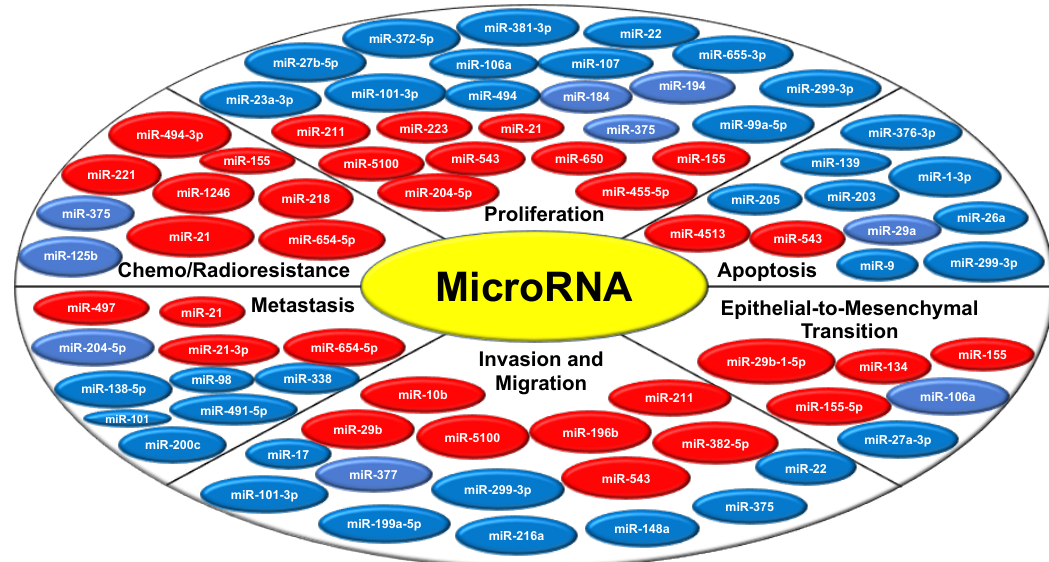
* The arrows illustrated in the first column of the table represent the expression levels of miRNA in oral cancer tissues/cell lines. The second column represent the targets of miRNA found in various studies. The third column indicates the mech- anism of action of these miRNAs in modulating various hallmarks of oral tumorigenesis. ↑ denotes increase and ↓ depicts decrease in either in expression/ function of miRNAs. Table 1. Different microRNAs and their targets involved in oral cancer initiation and progression.